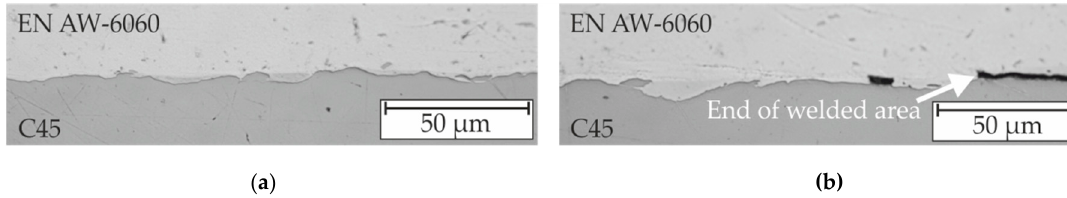
Figure 5. Polished cross section of the MPW sample joined with the Bmax setup ( g = 1.5 mm, E = 5.8 kJ, I max = 451 kA, Ø coil = 42 mm, w c = 10 mm, l w = 6 mm, welding direction from left to right, v i,r ≈ 340 m/s measured with photon Doppler velocimetry (PDV) [17]): ( a ) in the middle and ( b ) at the end of the joining zone.